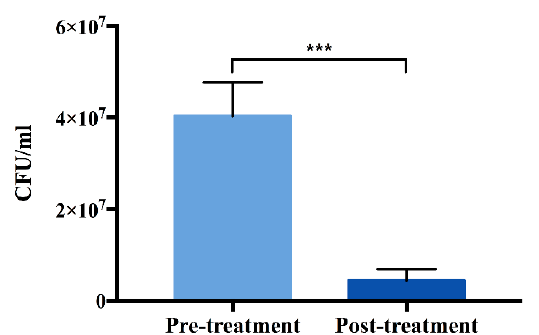
Figure 3. Effect of plasma treatment on decontamination. Data shown are the means ±SD ( n = 3). *** p < 0.001.